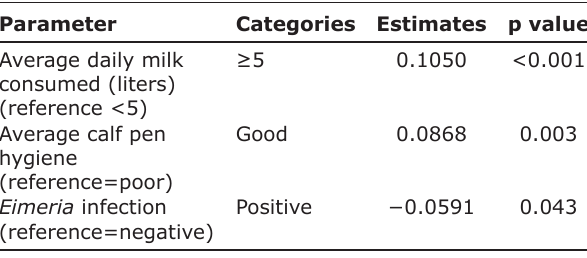
Table-5: Multivariable linear regression results of factors associated with average daily weight gain of 110 calves reared in 109 smallholder farms in Mukurwe-ini Sub-County,